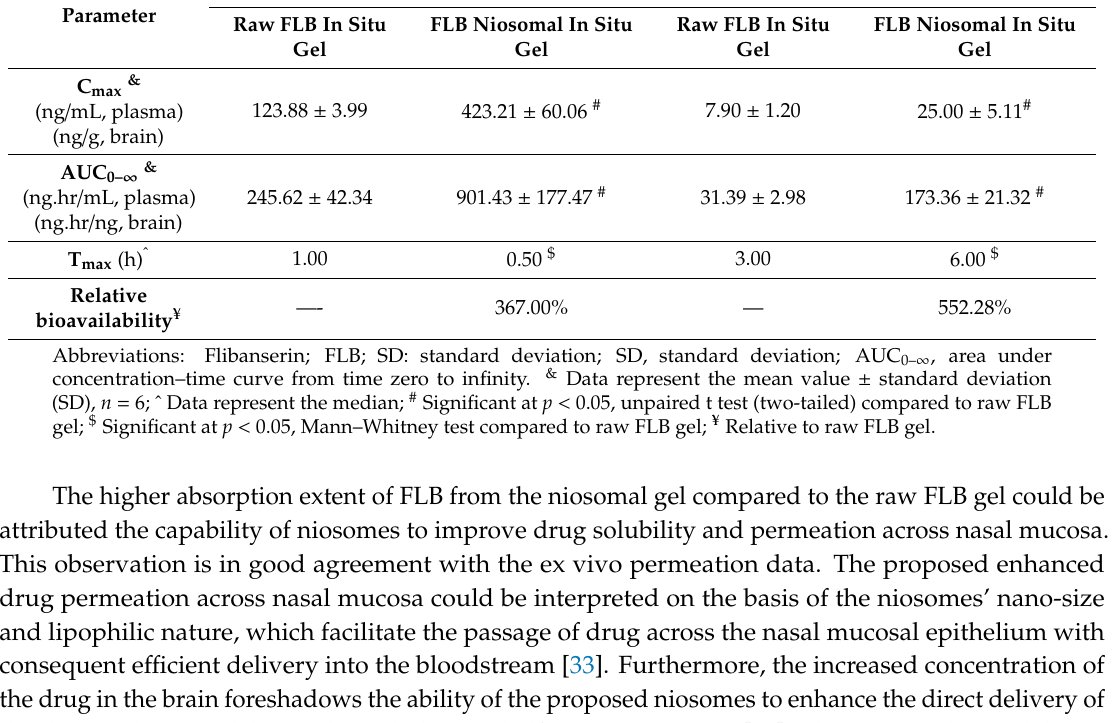
Table S1. Freeze-thaw cycles for the stability study of FLB